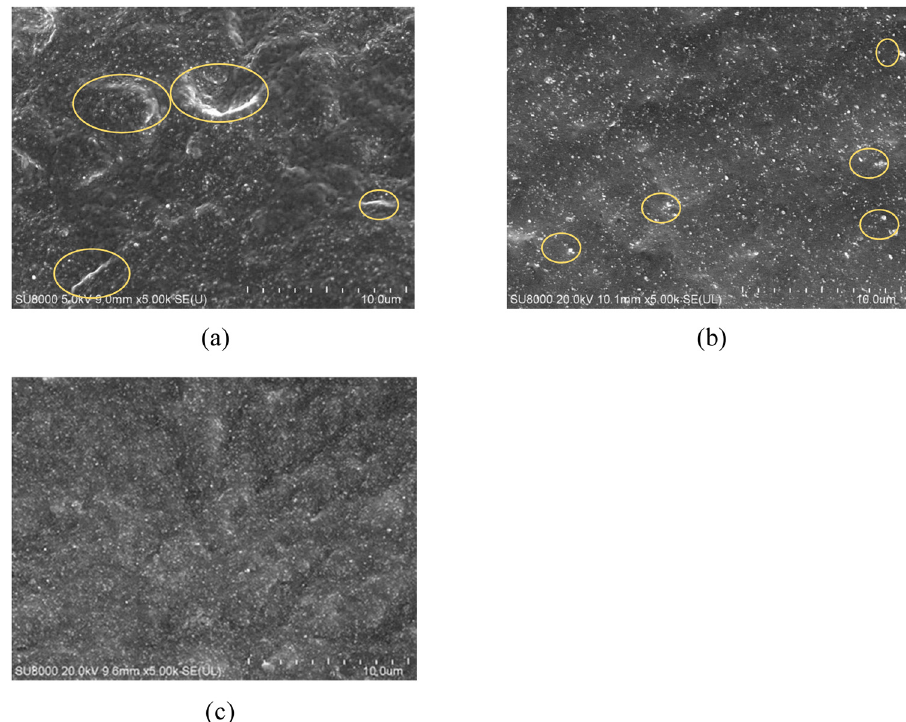
Figure 4: SEM images of composite preparation by spray sputtering method with a di ff erent type of silica: ( a ) silica commercially available, ( b ) in situ preparation from HCl solution, and ( c ) in situ preparation from NH